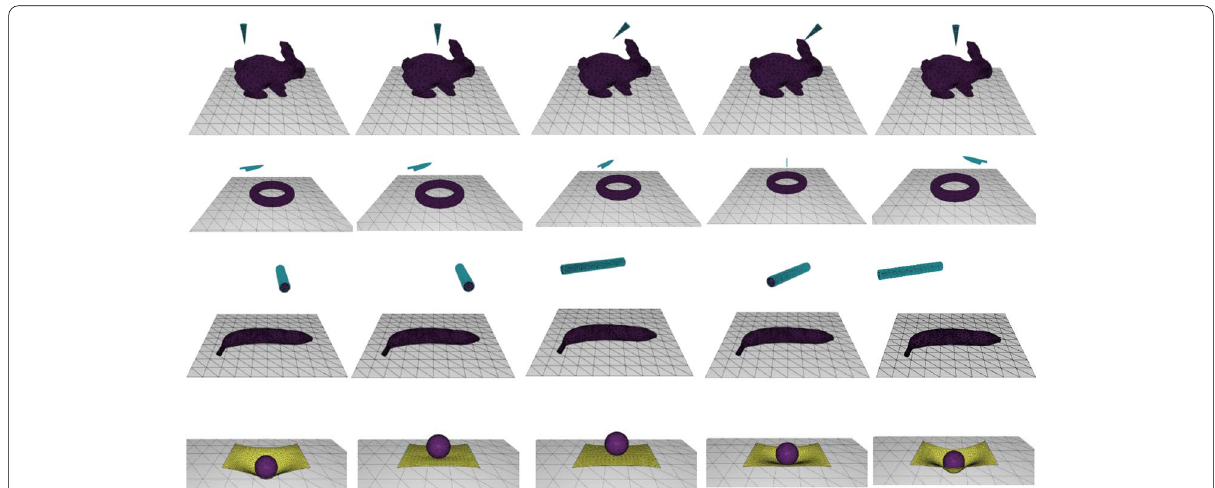
Fig. 5 Applying IPC [25] to generate the datasets used in this study. The IPC library can output accurate CDR simulation results